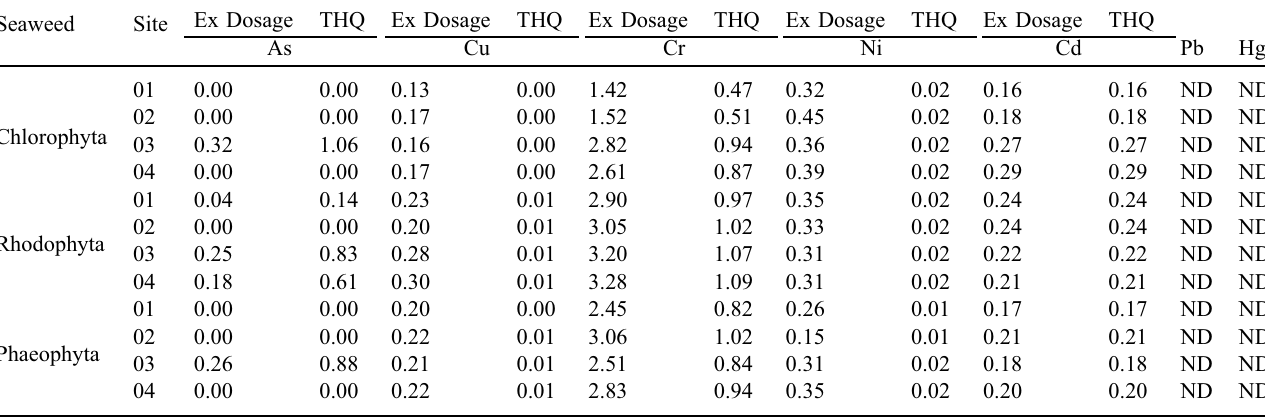
Table 5. Estimated exposure dosage and target hazard quotient for heavy metals (cid:1) North East Monsoon Season. Seaweed